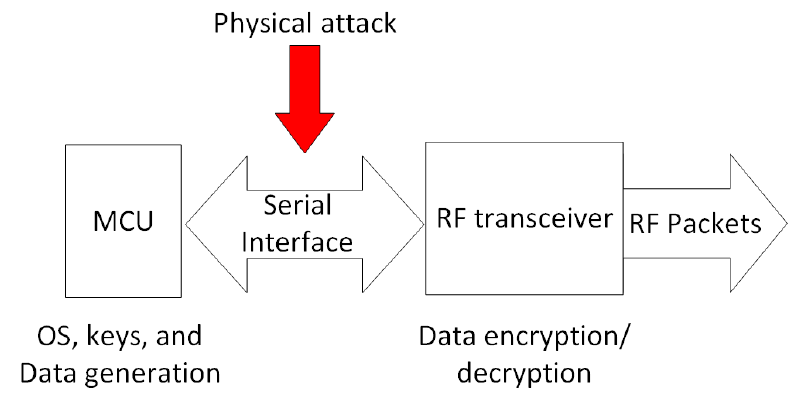
Figure 8. Physical attack of a typical and simplified IQRF node